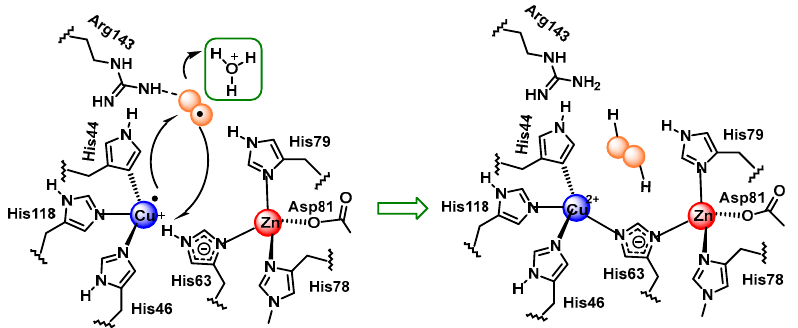
Figure 35. Second part of the reaction mediated by SOD1, transformation of the second O 2 •− into hydrogen peroxide and regeneration of the catalytic centre.